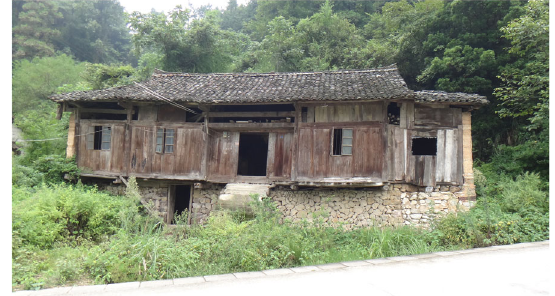
Fig. 10 Appearance of type-B house in Shuili Village (Source: the